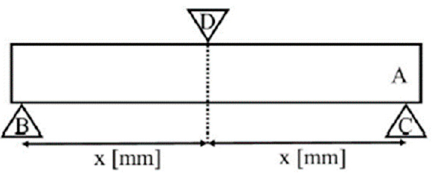
Figure 2. Flexural strength test diagram. Sample ( A ) is placed at an equal spacing on two supports ( B , C ). The third point is the load ( D ).